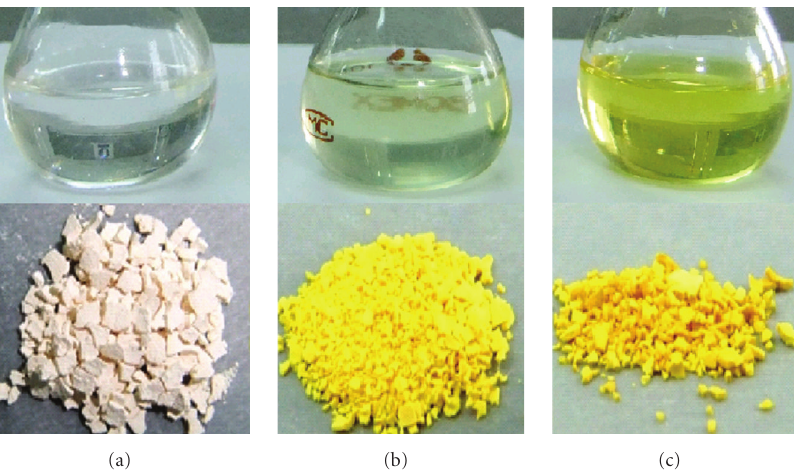
Figure 8: The images of poly(HQHEMA- co -St) and the corresponding Alq 3 - and Znq 2 -containing copolymers in solid and solution, respectively. (a) poly(HQHEMA- co -St); (b) Znq 2 -containing poly(HQHEMA- co -St); (c) Alq 3 -containing poly(HQHEMA- co -St). The concentration of 8-hydroxyquinoline moieties is 2.0 × 10 − 5 M for all the solutions.